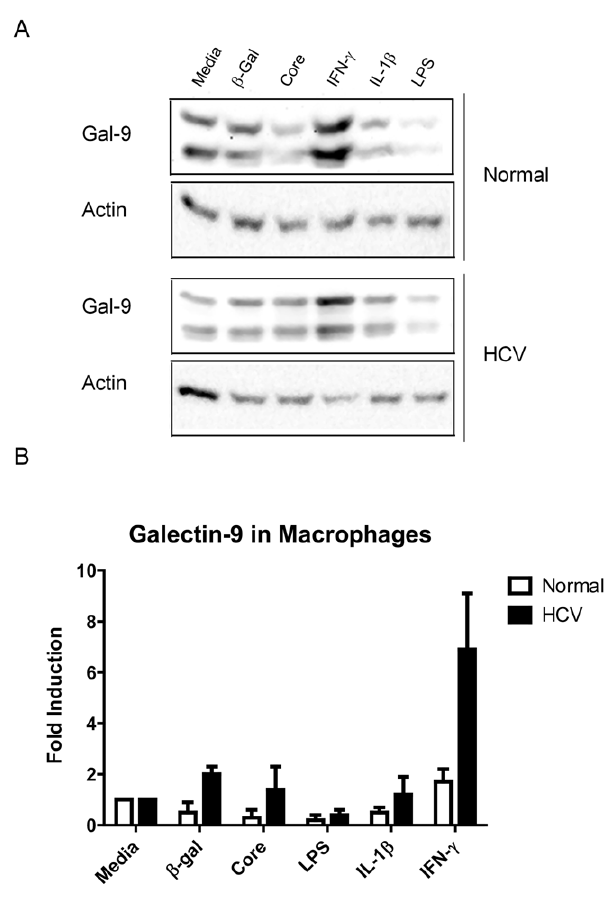
Figure 3. Interferon gamma increases galectin-9 levels in macrophages. CD14 positive cells from five normal controls and five HCV patients were bead selected from PBMCs and cultured for 48 hours with 25 ng/ml of MCSF to differentiate them into macrophages. Cells were stimulated for 48 hours with the stimuli shown at 2 6 10 6 /ml. IFN- c was used at 25 ng/ml, HCV core and b -gal were used at 10 ug/ml, LPS was used at 100 ng/ml, and IL-1 b was used at 10 ng/ml. Cell lysates were prepared and analyzed by Western Blot. ( A ) Western blot from one representative normal patient and one representative HCV patient to galectin-9 and b -Actin. ( B ) Fold induction was determined by densitometry using b -Actin as a loading control (n=4 normal, and 3 HCV-positive